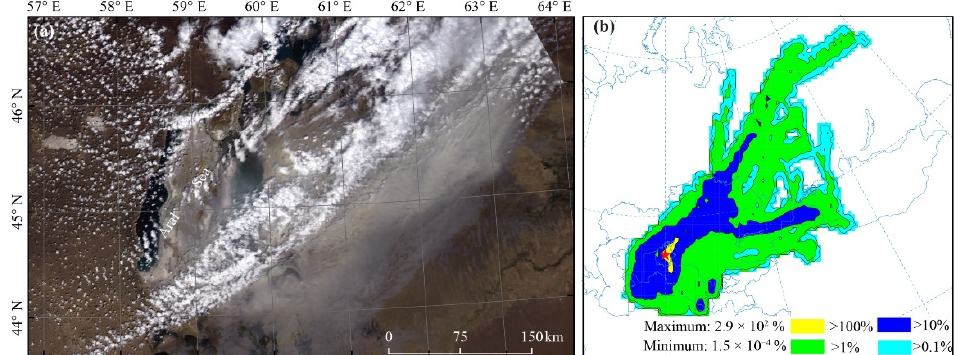
Figure 11. Sand and dust storm that occurred on 29 May 2018, captured by MODIS ( a ) and potential long ‐ range transport of the atmospheric aerosols from the Aral Sea Basin, derived from HYSPLIT model ( b